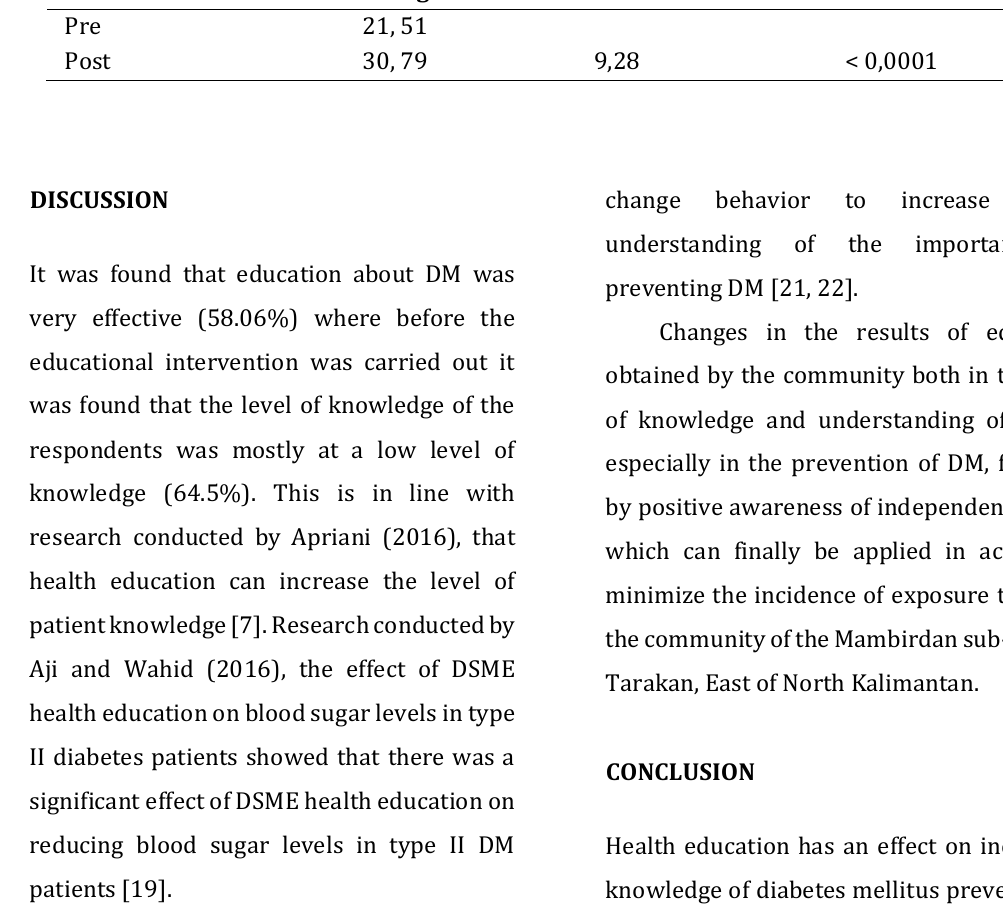
Results of Comparison of Pre and Post Intervention (n=31)